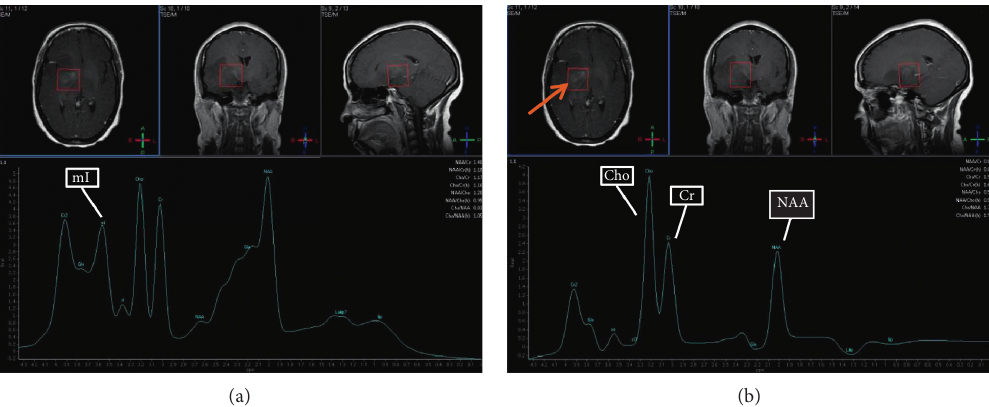
Figure 6: (a) TE 31 msec. (b) TE 144 msec. MRS was performed to differentiate between high-grade and low-grade glioma. The lesion was diagnosed as a low-grade glioma. NAA is depressed. Choline is moderately elevated. Cho: Cr is 1.67, and Cho :NAA is 1.90. Increased myo- inositol is also seen at TE31.